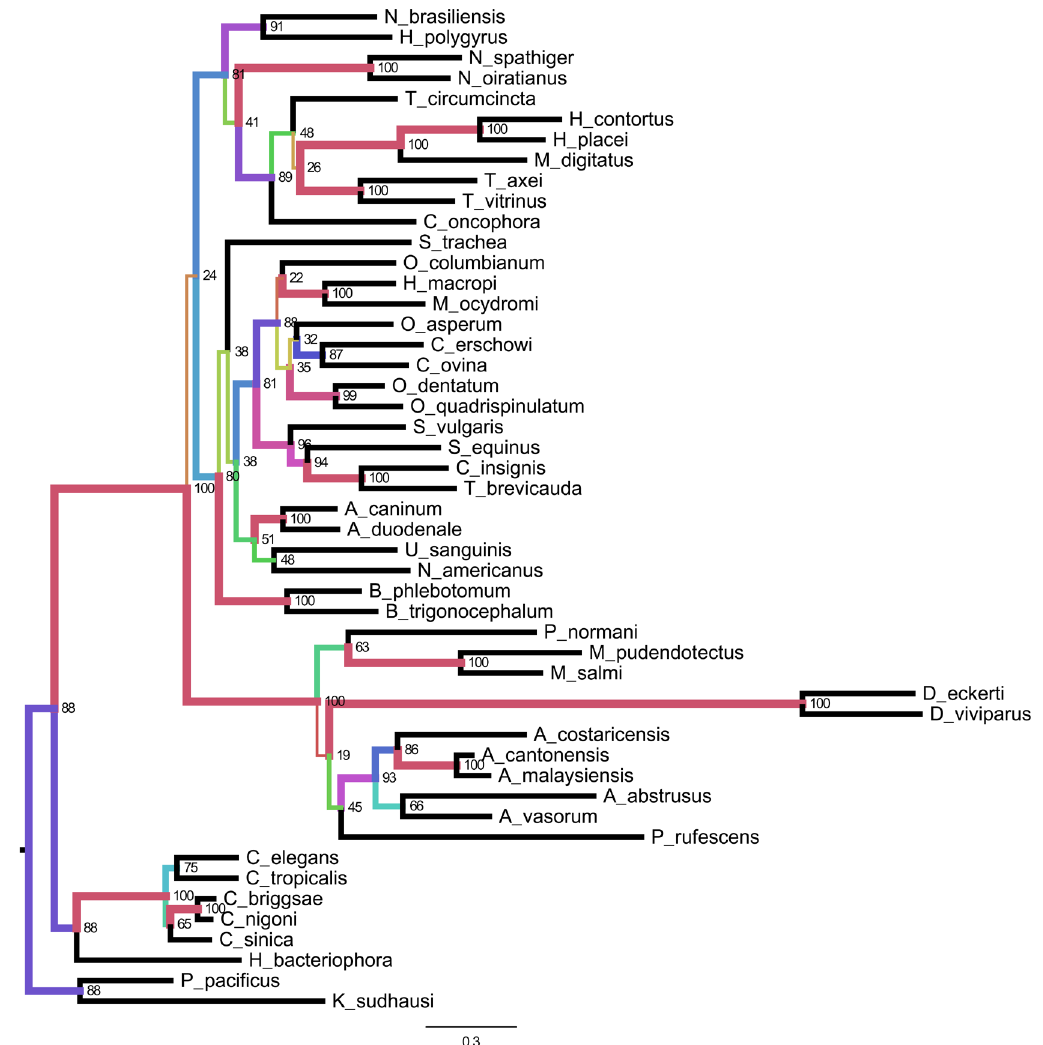
Figure 3. Phylogenetic tree for mtDNA. Phylogenetic tree based on evidence from three mitochondrial-encoded genes: cytochrome oxidase 1, l-rRNA , and cytochrome B . This tree demonstrates sequence similarities for 47 species from the Rhabditida together with two outgroups ( Pristionchus pacificus and Koerneria sudhausi ). Branch lengths are nucleotide substitutions per bp. Nodes are labelled with sub-sequence deletion bootstrap values. Branch colours and width are representative of bootstrap